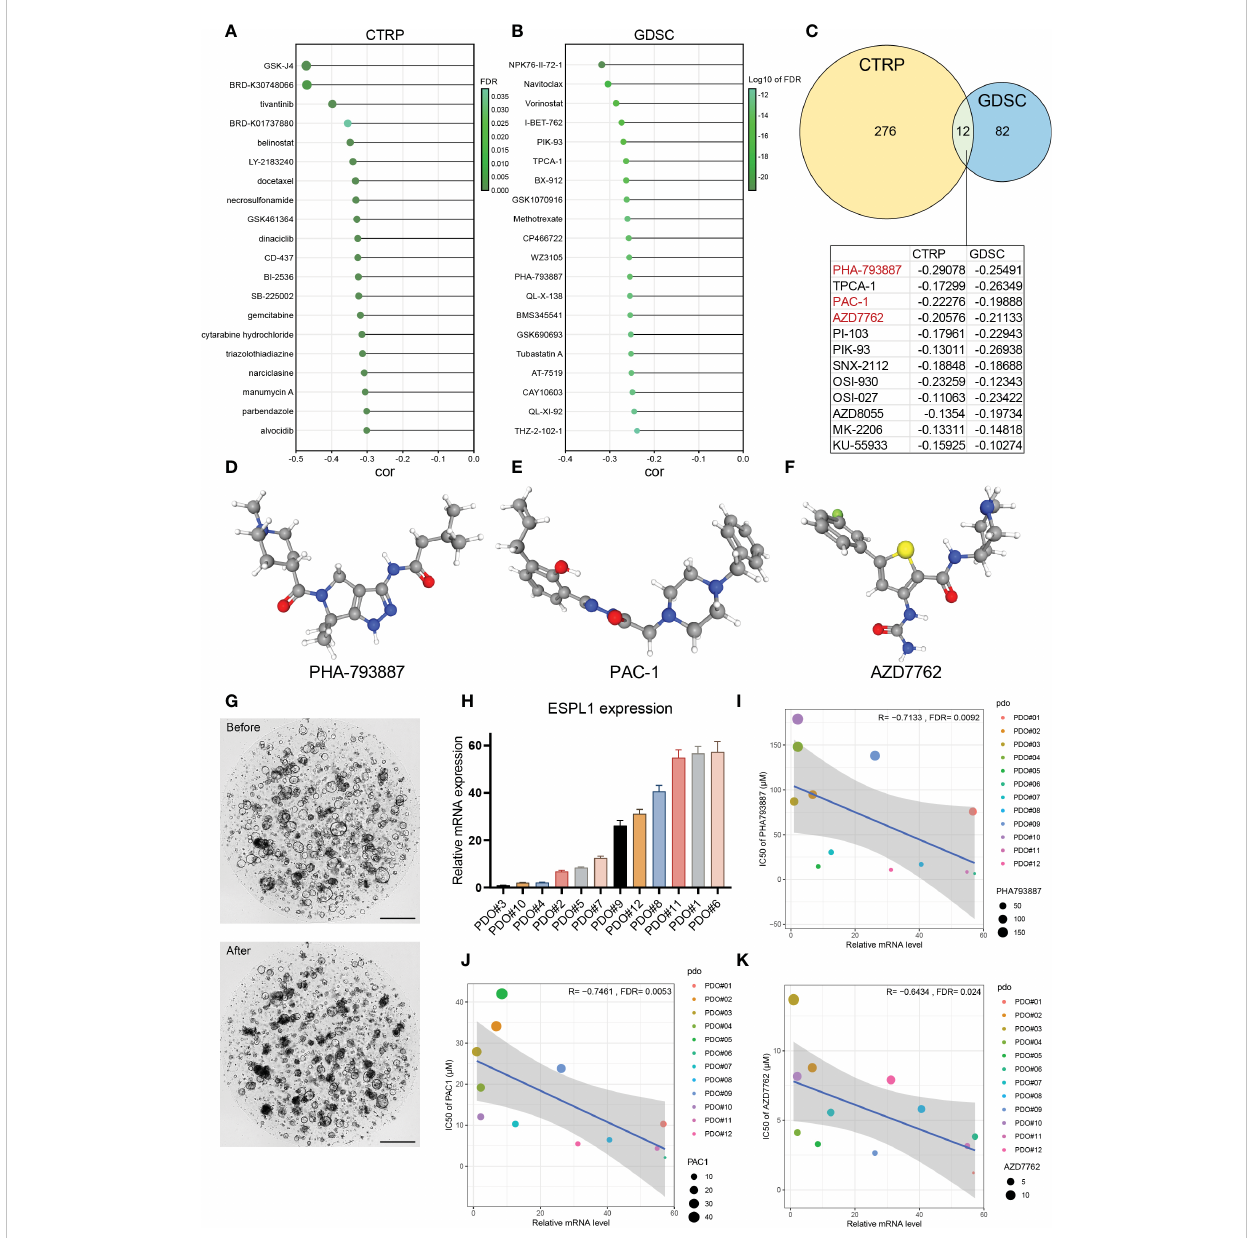
FIGURE 8 The relationship between ESPL1 and drug sensitivity. The drugs with the strongest correlation in ESPL1 expression were in the (A) CTRP and (B) GDSC databases. (C) Venn diagram of the results of the two databases. (D-F) The three-dimensional structure of drugs in PubChem. (G) Patient derived organoids (PDO) before and after coculture with drugs. Scale with 500 m M. (H) Expression level of ESPL1 in 12 PDOs. Correlation of ESPL1 expression in organoids with IC50 of (I) PHA793887, (J) PAC-1 and (K)